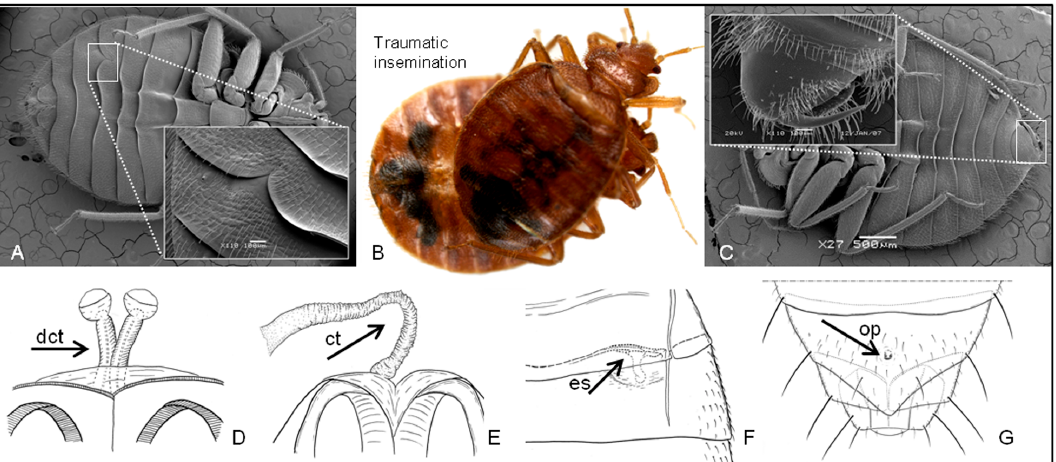
Figure 2. A copulation scene of traumatic insemination (TI) and various types of paragenitalia (PG) and male paramere. ( A , C ) Scanning electron microscope of Cimex lectularius ; ectospermalege and male paramere are magnified in dotted box. ( B ) TI between male (upper) and female (lower) ( Cimex lectularius ). ( D ) Blaptostethus aurivillus , representing double copulatory tube (dct) (modified after Yamada (2008) [17]); ( E ) Scoloposcelis albodecussata , representing copulatory tube (ct) (modified after Yamada and Hirowatari (2005) [18]); ( F ) Xylocoris cerealis representing ectospermalege (es) (modified after Yamada et al. (2006) [19]); ( G ) Buchananiella pericarti representing omphalus (op) (modified after Yamada and Yasunaga (2009) [20]).